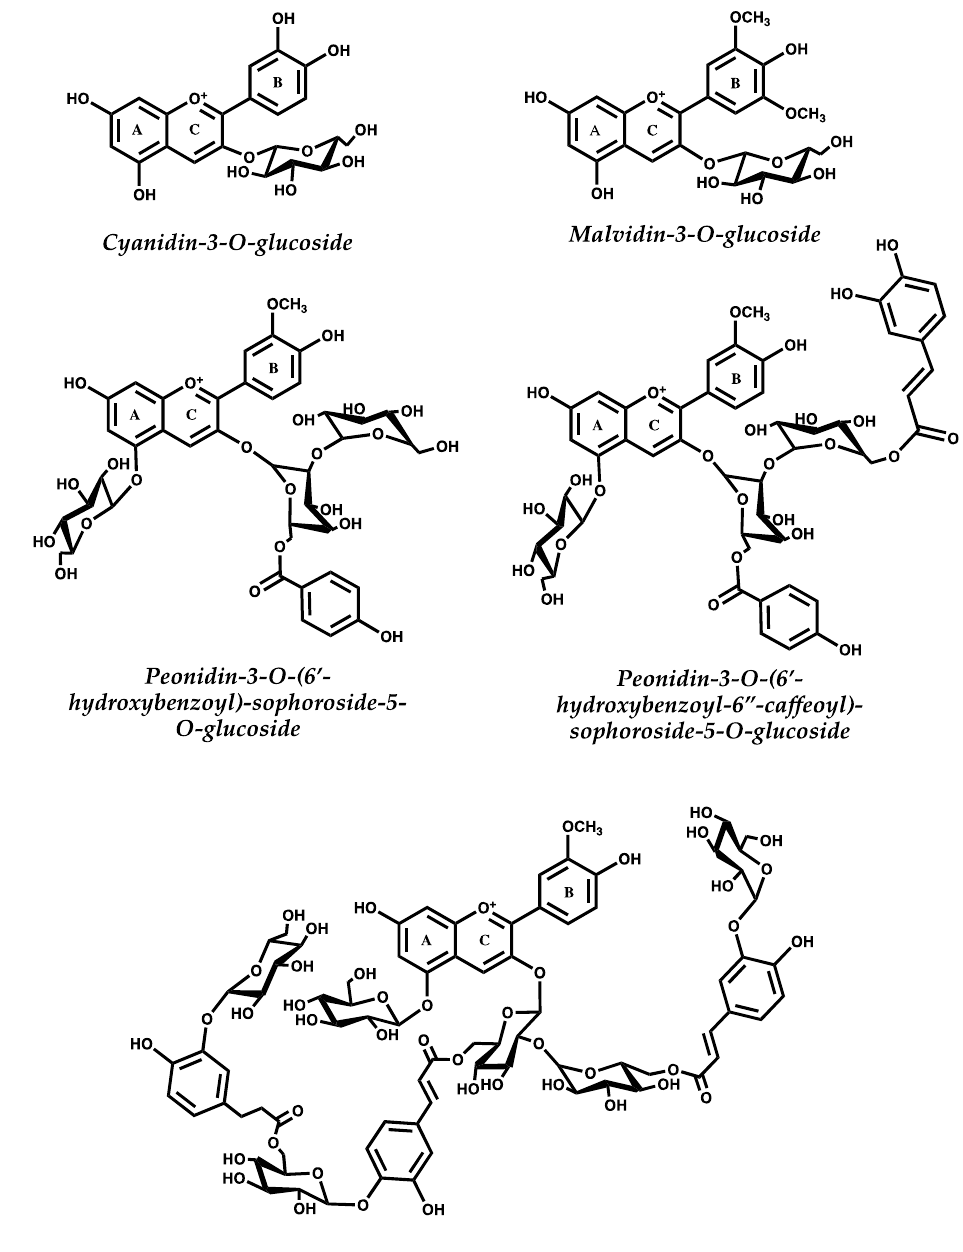
Figure 1. Anthocyanins structure from different sources. Cyanidin-3-O-glucoside is the most abundant anthocyanin in nature and can be found in several fruits. Malvidin-3-O-glucoside is the main anthocyanin from Red Wine and grapes from Vitis vinifera [4] . Peonidin-3-O-(6’- hydroxybenzoyl)-sophoroside-5-O-glucoside and Peonidin-3-O-(6’-hydroxybenzoyl-6’’-caffeoyl)- sophoroside-5-O-glucoside are normally found in vegetables such as Purple Sweet Potato [5] . HBA acylated anthocyanin—a 3-O-(2-O-(6-O-(trans-3-O-( β -D-glucopyranosyl)-caffeoyl)- β -D- glucopyranosyl)-6-O-(trans-4-O-(6-O-(trans-3-O-( β -D-glucopyranosyl)-caffeoyl)- β -D- glucopyranosyl)-caffeoyl)- β -D-glucopyranosyl)-5-O-( β -D-glucopyranosyl)-Peonidin—is typically found in Heavenly Blue Morning Glory Ipomoea tricolor flowers [6] .